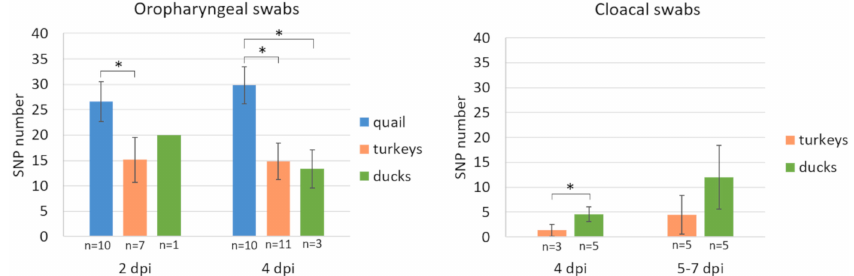
Figure 2. Average numbers of single nucleotide polymorphisms (SNPs) present in virus populations of oropharyngeal and cloacal swabs collected from birds infected with H9N2 AIV. The asterisks (*) show the statistically significant di ff